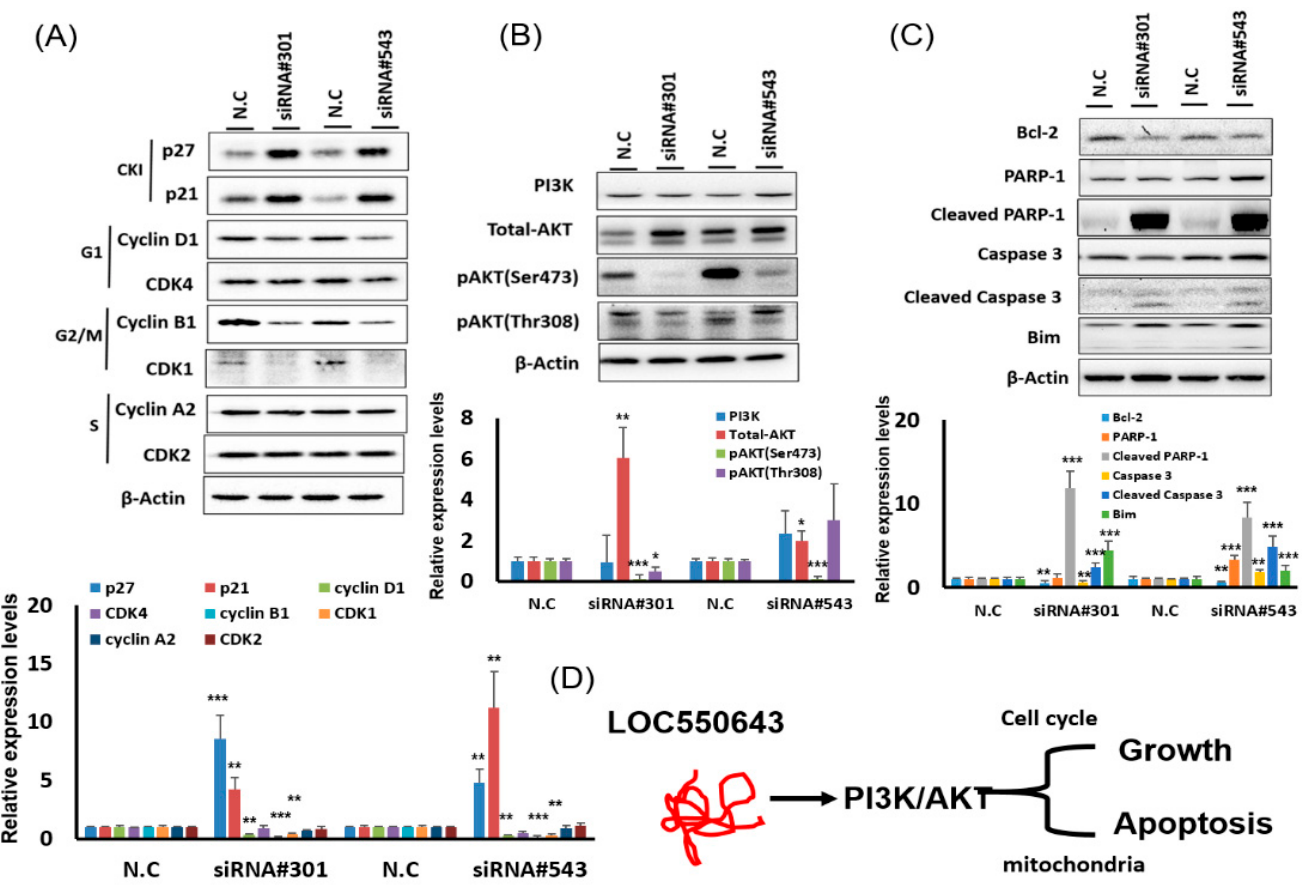
Figure 4. LOC550643 knockdown suppressed colon cancer cell growth through the modulation of phosphoinositide 3-kinase (PI3K) signaling activation. ( A ) Western blotting was conducted to assess the expression levels of cell cycle–related proteins in HCT116 cells with LOC550643 knockdown. Relative expression was further quantification (below panel). ( B ) PI3K signaling-related proteins were examined in HCT116 cells with LOC550643 knockdown. Relative expression was further quantification (below panel). ( C ) Apoptosis-associated protein was assayed in HCT116 cells with LOC550643 knockdown. Relative expression was further quantification (below panel). ( D ) Putative mechanisms of LOC550643 knockdown–induced cell growth inhibition and apoptosis induction were determined (* p < 0.05, ** p < 0.01, *** p <